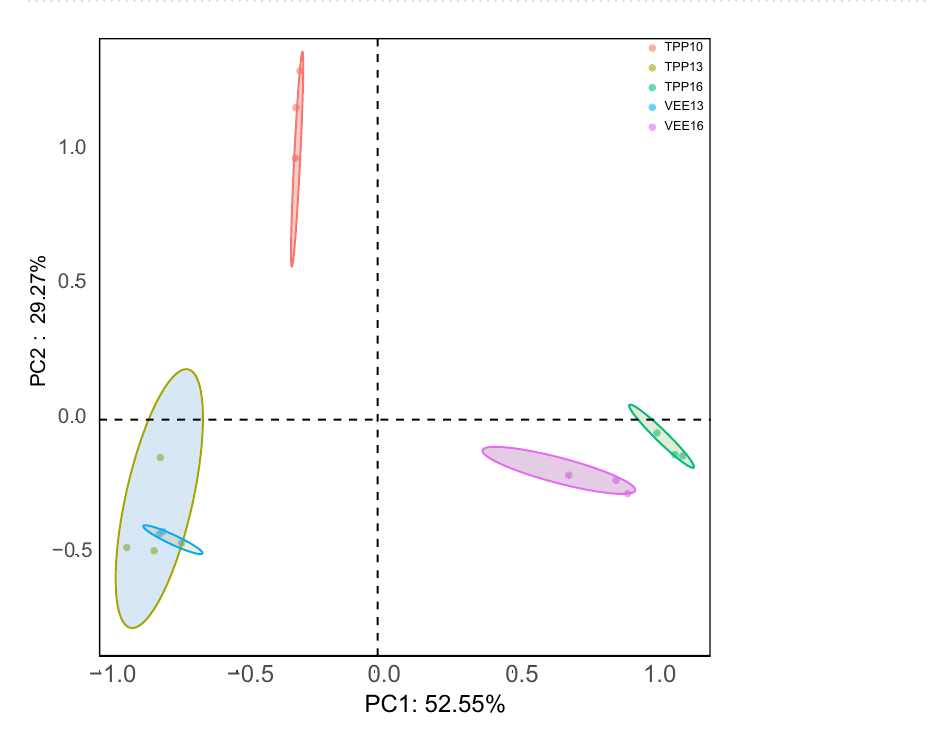
Figure 4. PCoA of the influence of two planting patterns on the diversity of soil